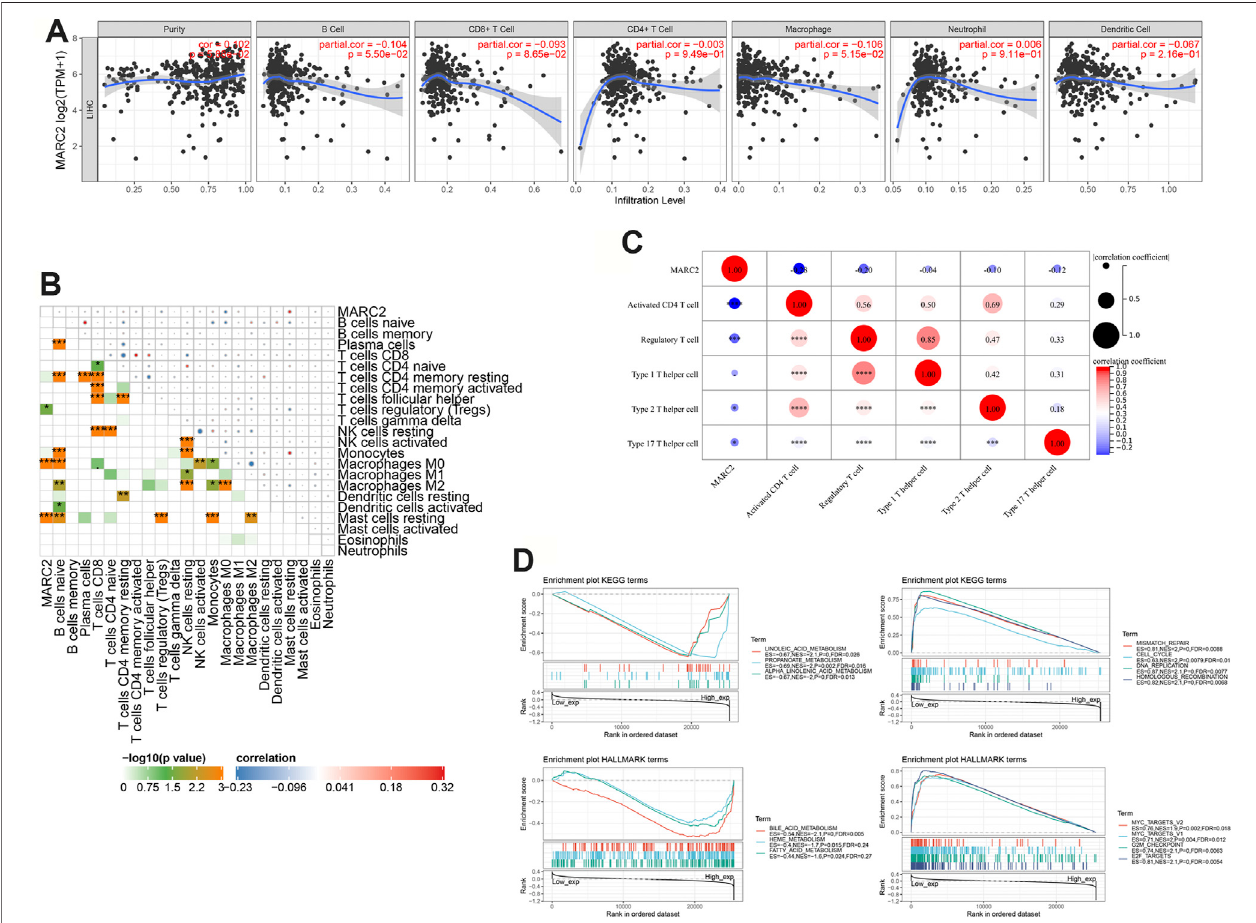
FIGURE 3 | The expression of MARC2 was associated with tumor immune microenvironment modi fi cation and lipid metabolism. (A) Correlation between MARC2 and tumorin fi ltratingimmunecell. (B) Thecorrelation betweenMARC2and immunecelltype. (C) Thecorrelation betweenMARC2and CD4+Tcellrelated differentiation subgroups. (D) Signaling pathways signi fi cantly correlated with MARC2. Data was generated by GSEA. The Pearson correlation coef fi cient was used to determine the correlation. *p < 0.05; **p < 0.01; ***p < 0.001; ***p < 0.0001.